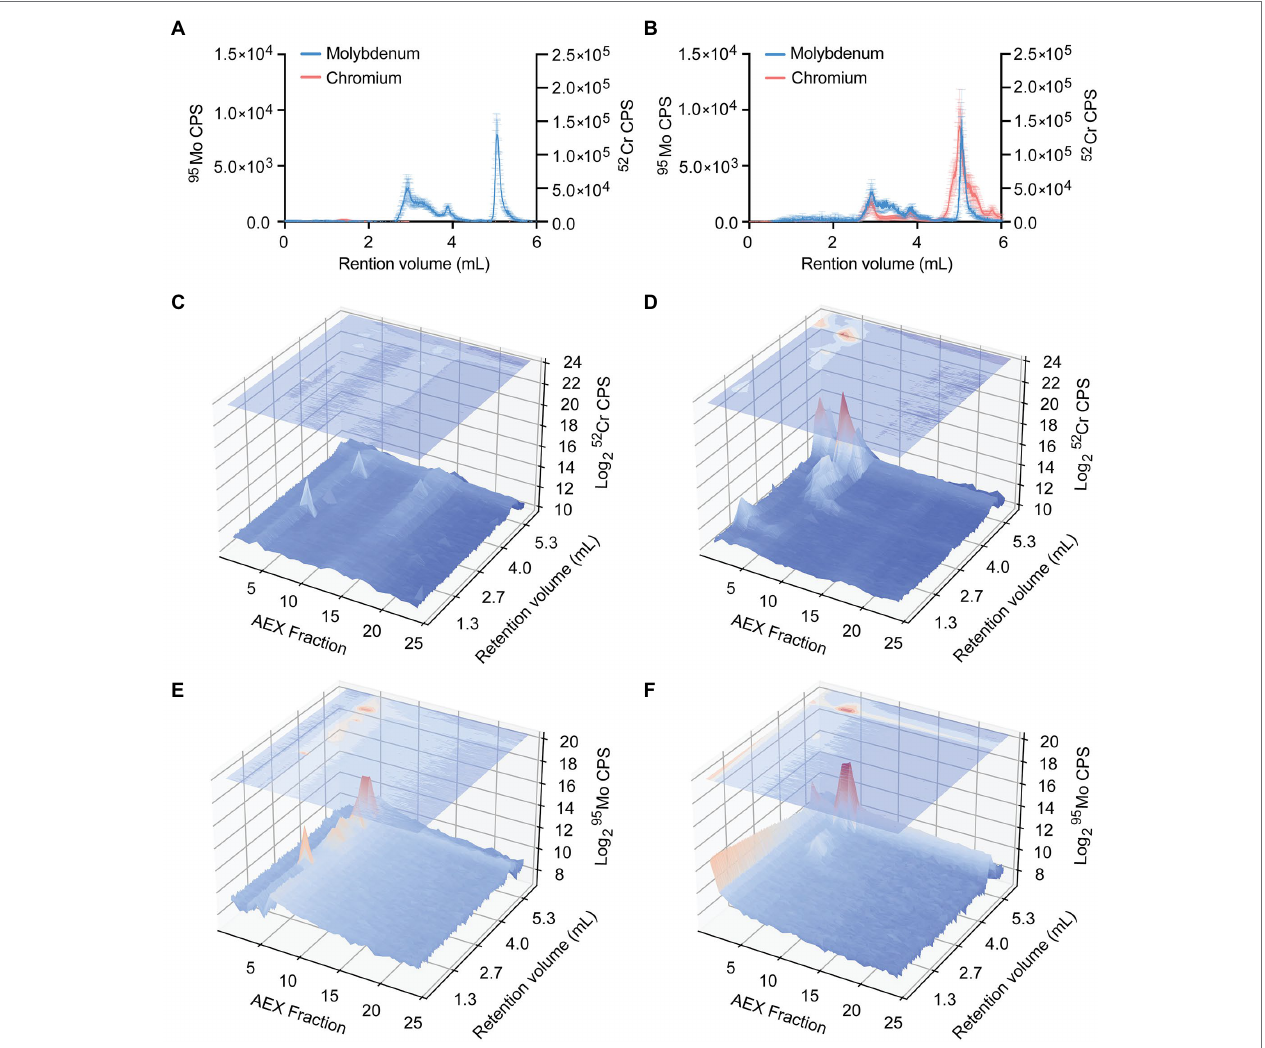
FIGURE 8 | Distribution of chromium and molybdenum within P. aeruginosa cell lysates. Size exclusion chromatography (SEC)-ICP-MS chromatograms (counts- per-second, CPS) of chromium and molybdenum P. aeruginosa PAO1 lysates from cultures grown in (A) M-CDM and (B) M-CDM supplemented with 32 μ M K 2 CrO 4 . Data represents the mean (±SEM) of three independent experiments. Representative P. aeruginosa lysates fractionated by anion exchange (AEX; x -axis) and further separated by SEC with online ICP-MS hyphenation (SEC; y -axis) overlayed over chromatograms (log 2 -CPS; z -axis) of chromium (C,D) and molybdenum (E,F) . Chromium chromatograms of P. aeruginosa lysates from cultures grown in (C) M-CDM, and (D) M-CDM supplemented with 32 μ M K 2 CrO 4 . Molybdenum chromatograms of P. aeruginosa lysates from cultures grown in (E) M-CDM and (F) M-CDM supplemented with 32 μ M K 2 CrO 4